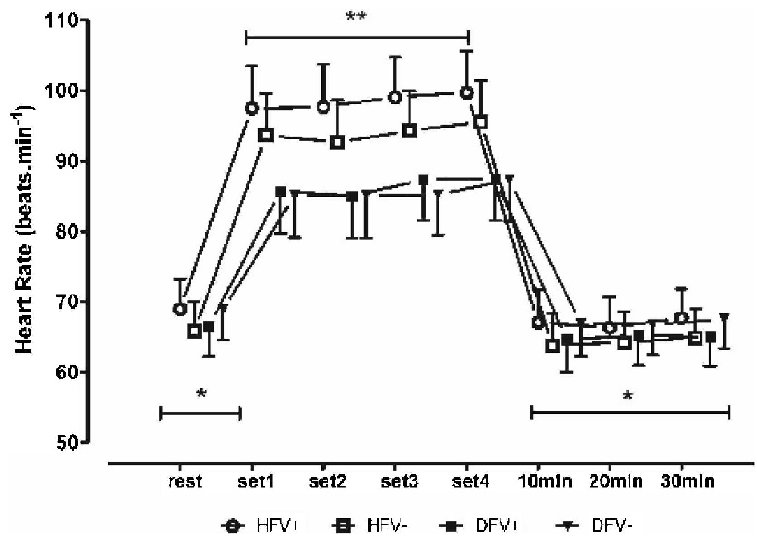
Figure 2 - The heart rate at rest, at the end of each stretching set, and 30 min post-exercise. Within-group comparison, -. *, significant differences in all sets (a: HFV + , hip flexion with Valsalva; b: HFV-, hip flexion without Valsalva; c: DFV + , dorsiflexion with Valsalva; d: DFV-, dorsiflexion without Valsalva) (p , .05). Between-group comparison, -. **, significant differences for HFV + and HFV- as compared to DFV + and DF- across all sets. The vertical bars denote 0.95 confidence intervals.